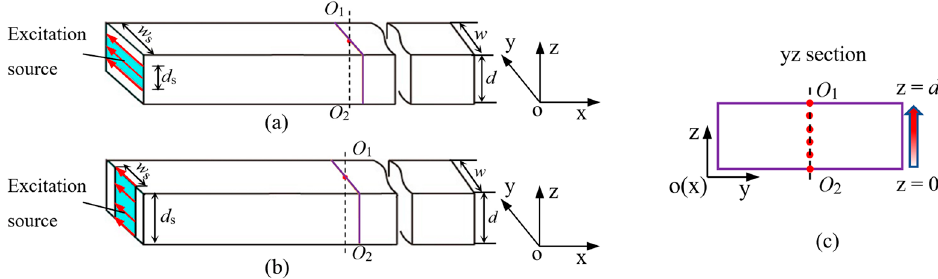
Figure 4. Locations of the excitation sources in the end section of the waveguide bar: ( a ) Equal width symmetric match; ( b ) Equal thickness symmetric match; ( c ) Analyzed nodes in the cross section of the waveguide bar.